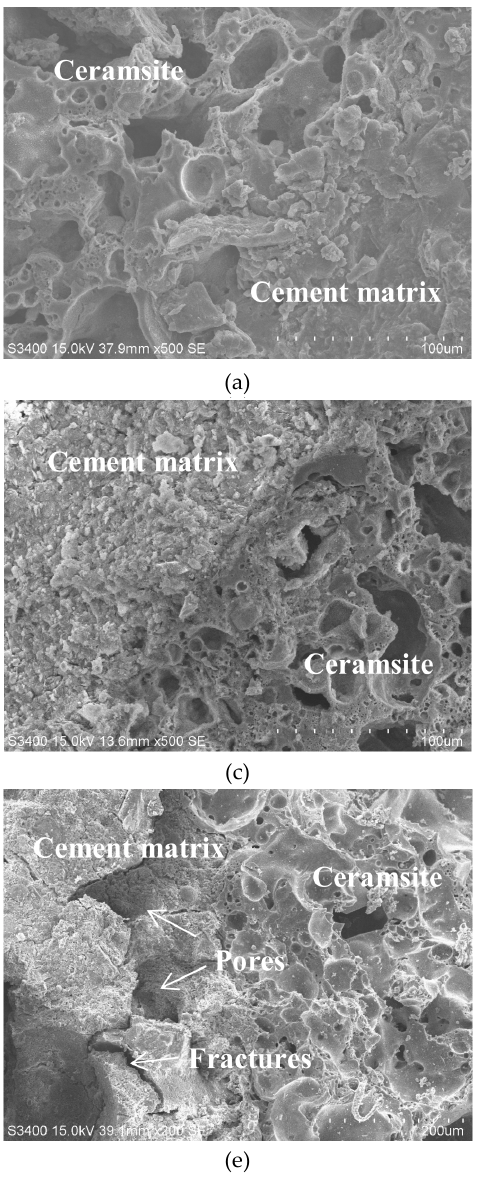
Figure 11. Micro-structures of interfacial transition zone of LC-100 after exposure to different temperature: ( a ) 20 ° C, ( b ) 200 ° C, ( c ) 400 ° C, ( d ) 600 ° C, ( e ) 800 ° C, ( f ) 1000 ° C .